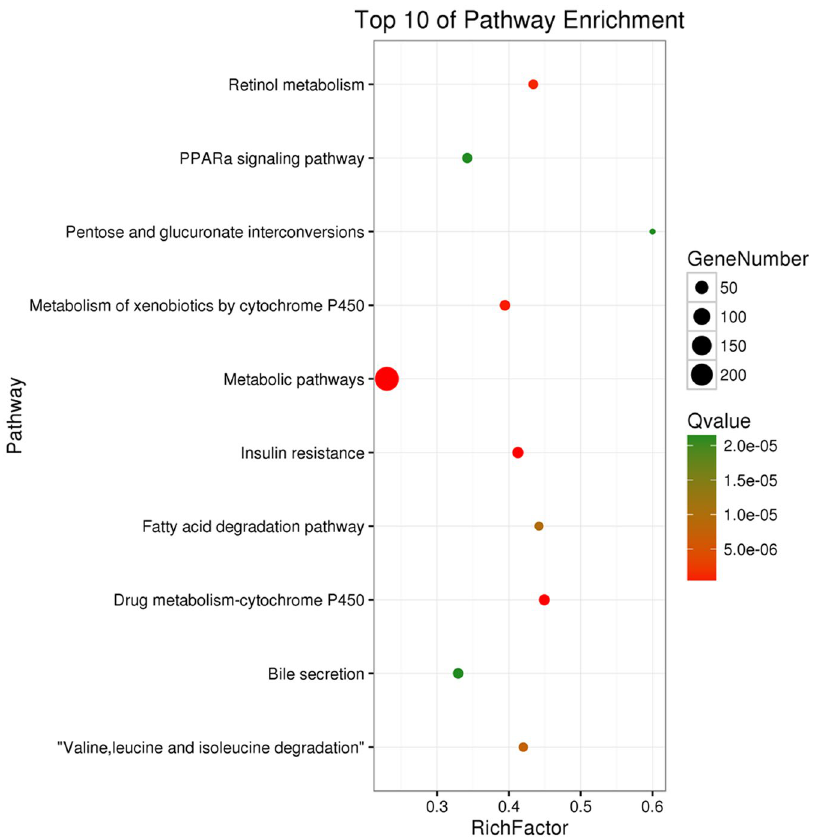
Figure 5. Scatter plot for KEGG enrichment results. The top 10 enrichment pathways are shown in the senior bubble chart. The Rich factor is the ratio of DEGs numbers annotated in this pathway term to all gene numbers annotated in this pathway term. A Q value is the corrected p